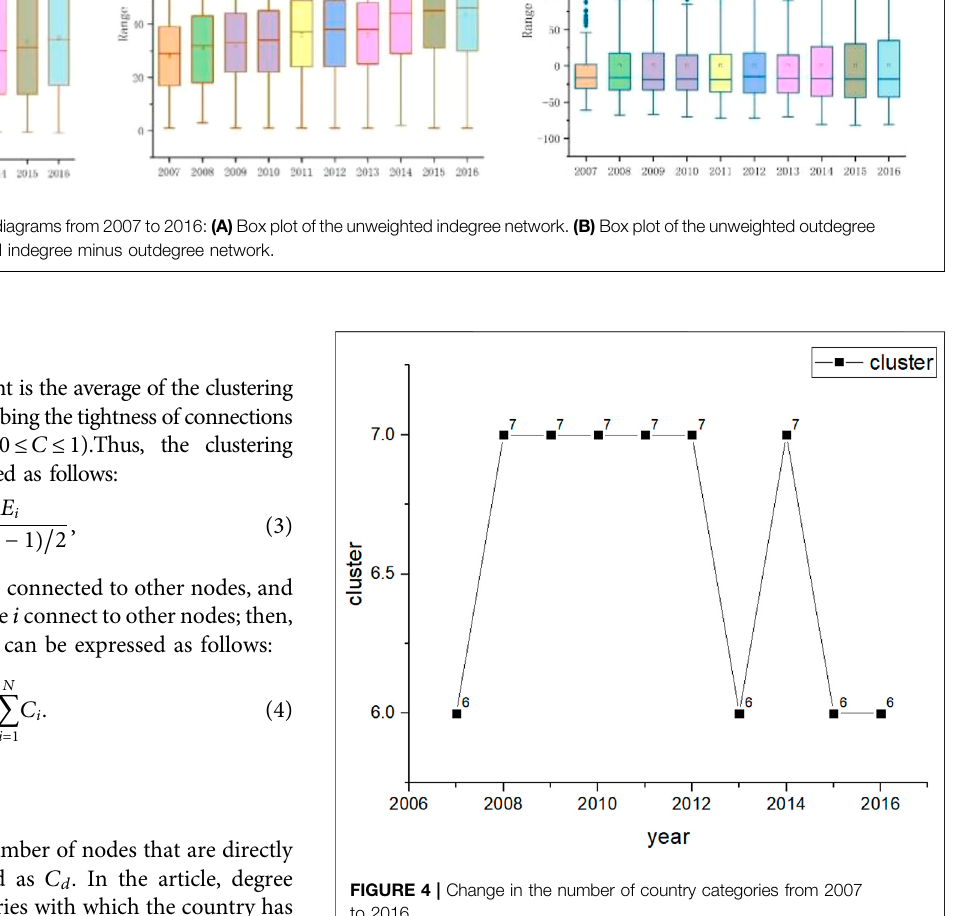
FIGURE 4 | Change in the number of country categories from 2007 to